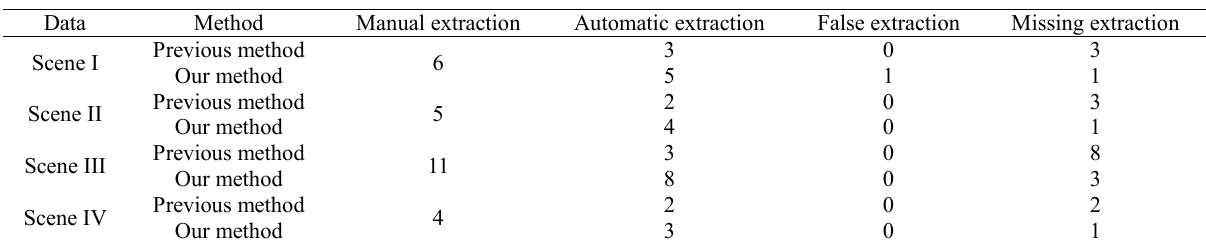
Table 2 Performance comparison between different